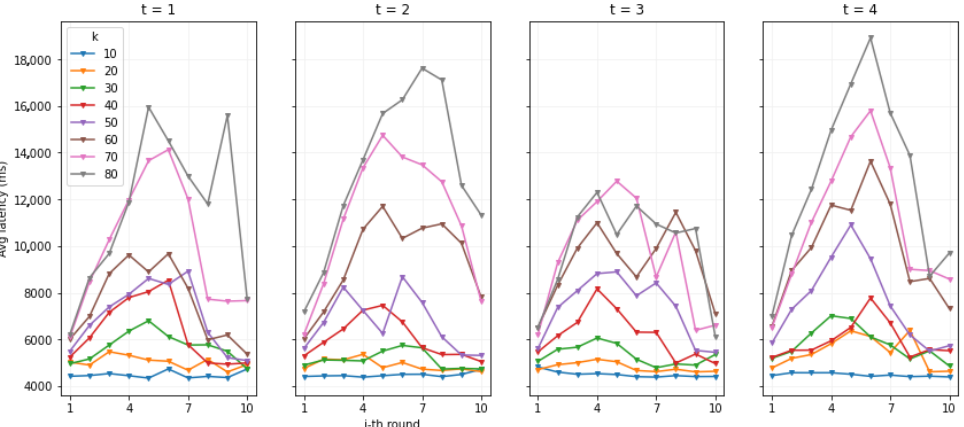
Figure 12. Average response latency when increasing the threshold t value and the number of owners k for each i -th